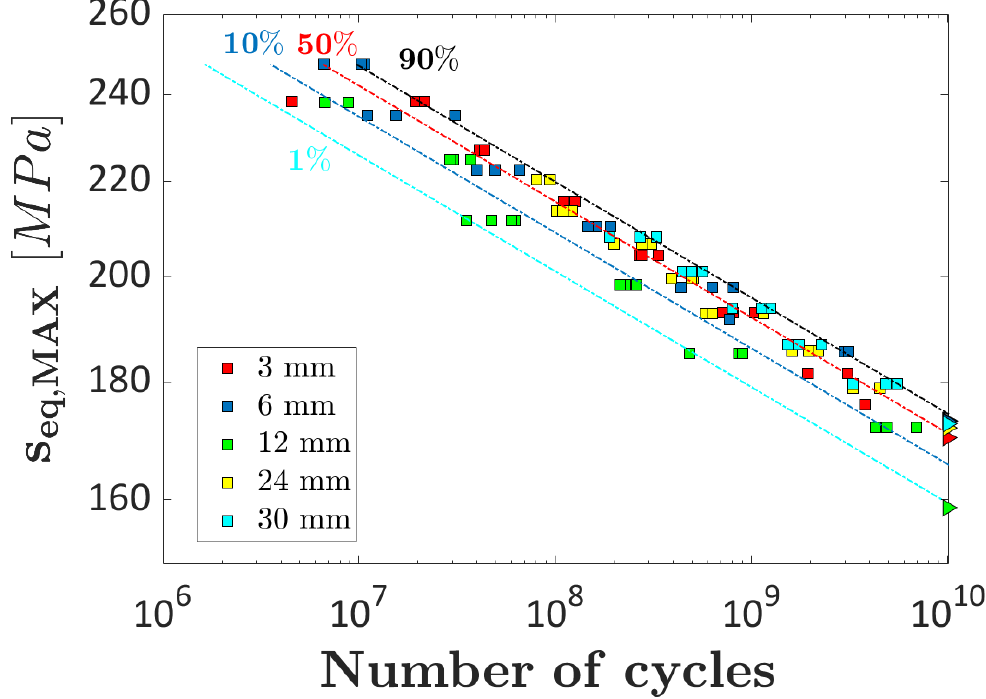
Figure 6. Plot of s eq , MAX with respect to the number of cycles to failure: experimental data and estimated 90%, median, 10% and 1% quantile